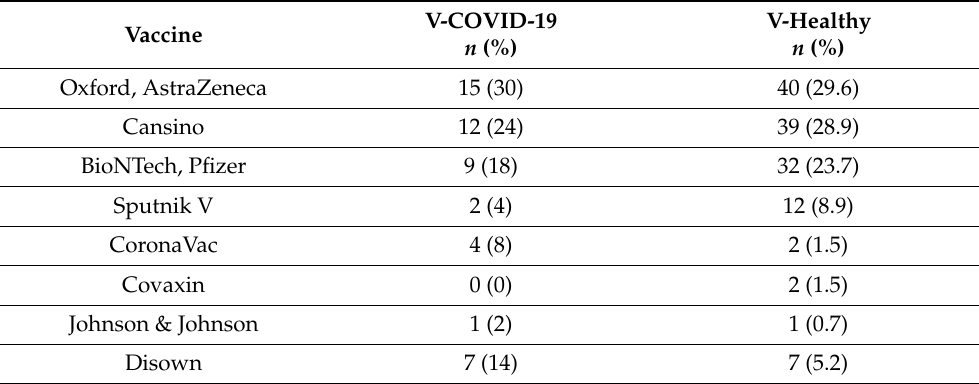
Table 2. Distribution of the vaccines in the study groups.